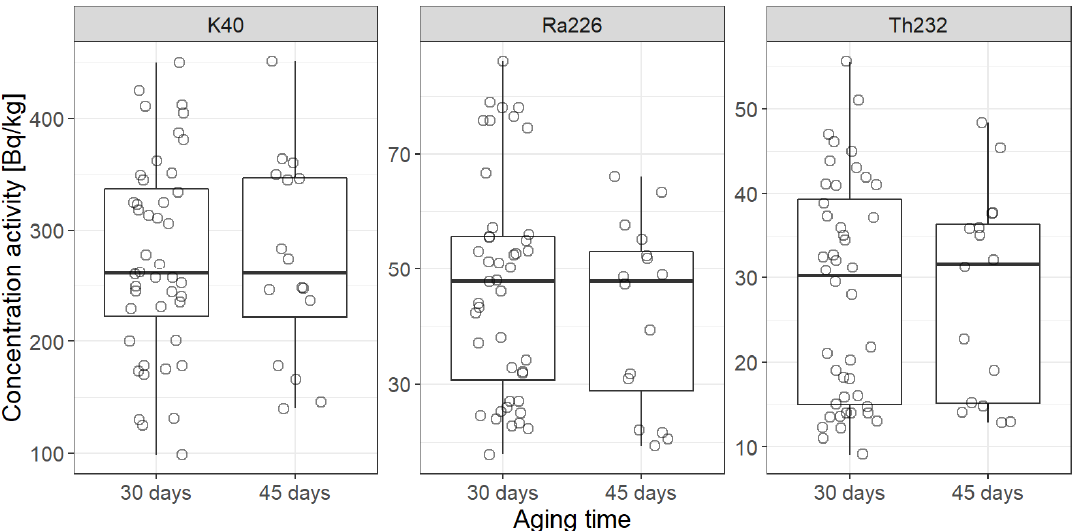
Figure 8. Comparison of activity concentration of the natural radionuclides in the case of 30-d aging vs. 45-d aging. The comparison is made with the use of box-whisker plots. Medians in all cases are almost equal.